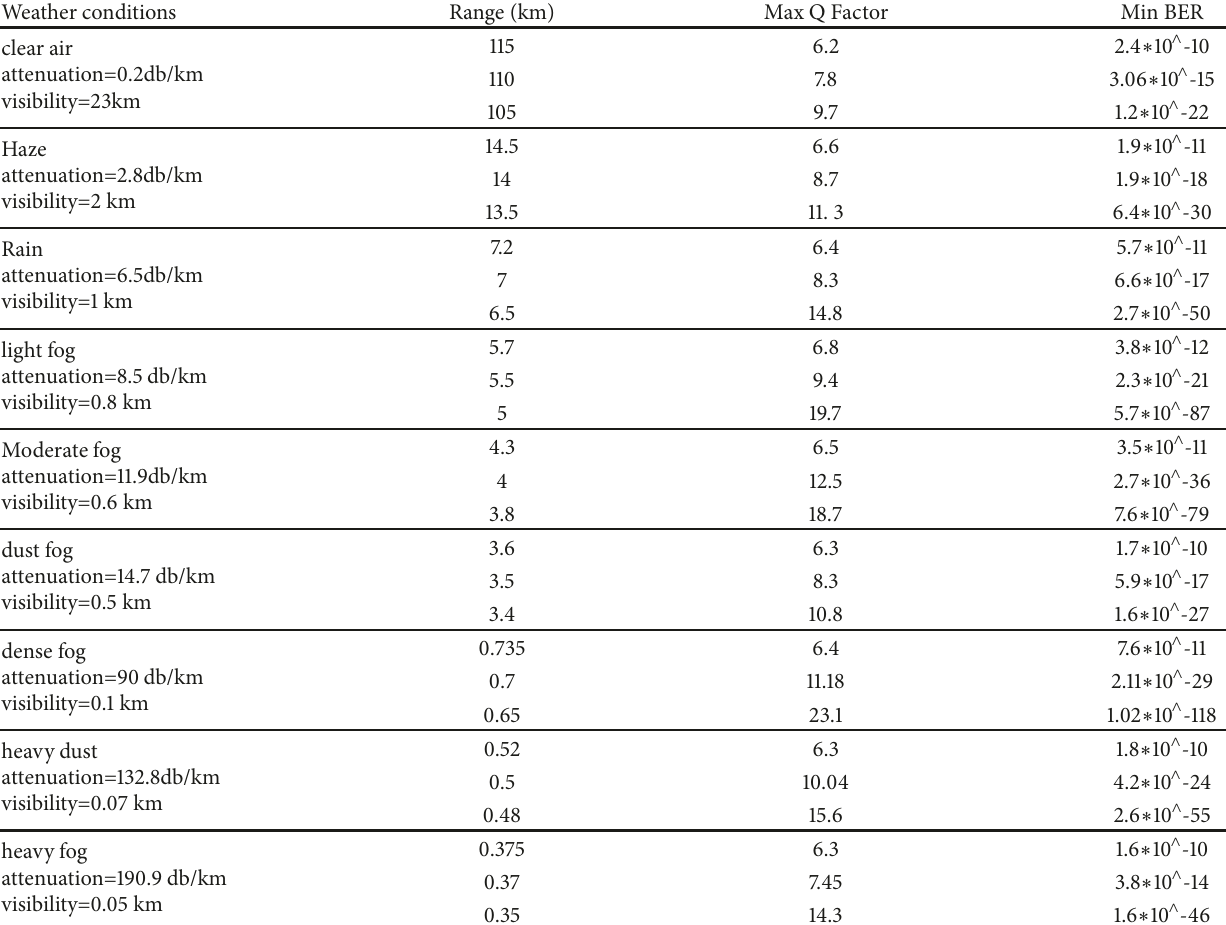
Table 4: Results for 2T X /2R X FSO at different weather conditions for 𝜆 = 1550 nm.